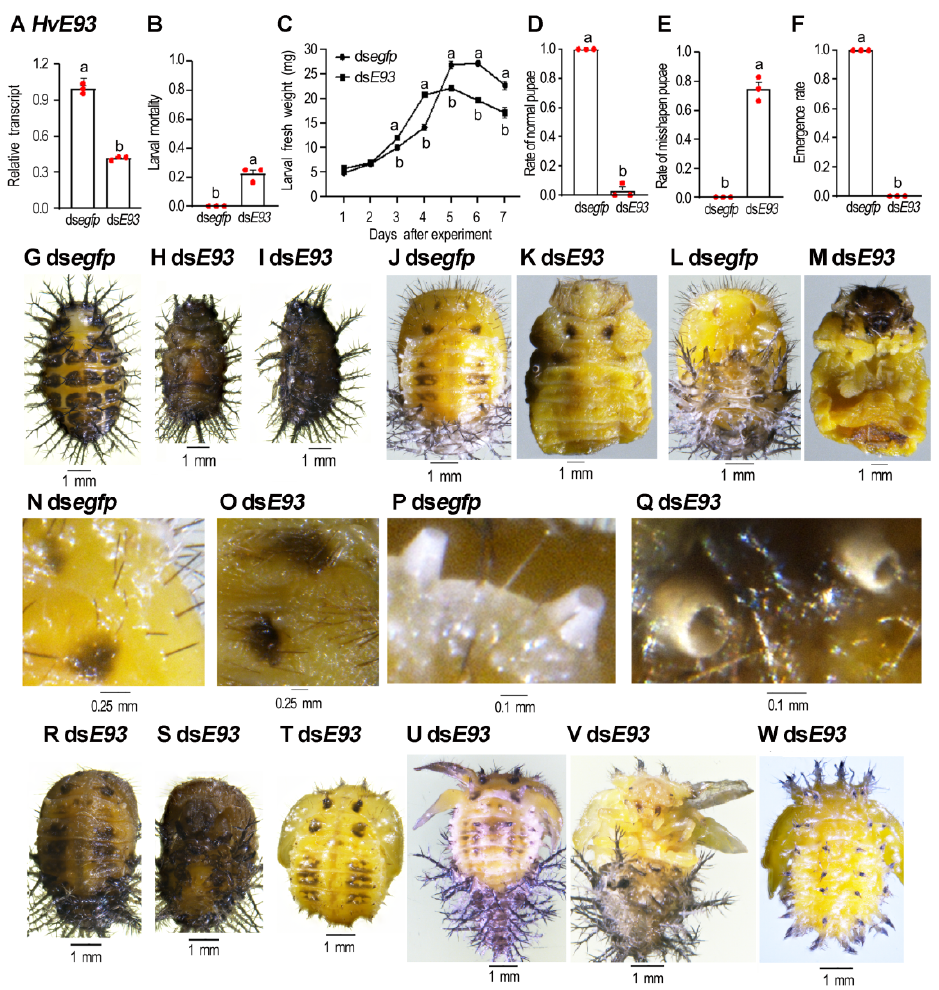
Figure 3. Knockdown of both HvE93 isoforms in the penultimate instar larvae impair larval-pupal-adult transition in Henosepilachna vigintioctopunctata . Around 300 ng of ds E93 or ds egfp (0.1 μ L) was injected into the newly molted third instar larvae. The ladybirds were subsequently confined in petri dishes containing potato foliage. Three days after injection, the expression level (2 −ΔΔ CT values) of HvE93 was measured ( A ). The larval mortality ( B ), rates of normal and deformed pupae ( D , E ), and emergence rate ( F ) were recorded during a 3-week trial period. The resultant larvae were weighed 1 through 7 days after treatment ( C ). Statistical significances ( p value < 0.05, showing by different letters above the columns) between treatment and control (means ± SE) were calculated using an independent sample t -test. Dorsal ( G , H ) and lateral ( I ) views of arrested larvae are shown. After the removal of the larval exuviae, the dorsal ( K ) and ventral ( M ) views of the resultant prepupae are shown, compared with the control pupae ( J , L ). The black markings and pupal spines ( O vs. N ), and two abdomen spiracles ( Q vs. P ) of treated and control beetles are further amplified. The dorsal ( R , T , U , W ) and ventral ( S , V ) views of the resultant E93 RNAi pupae showed the defective phenotypes.